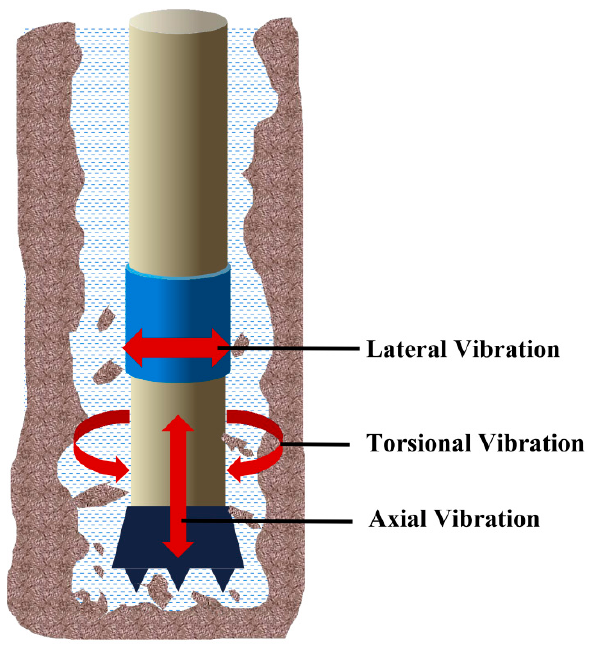
Figure 4. Schematic diagram of drill string vibration pattern.